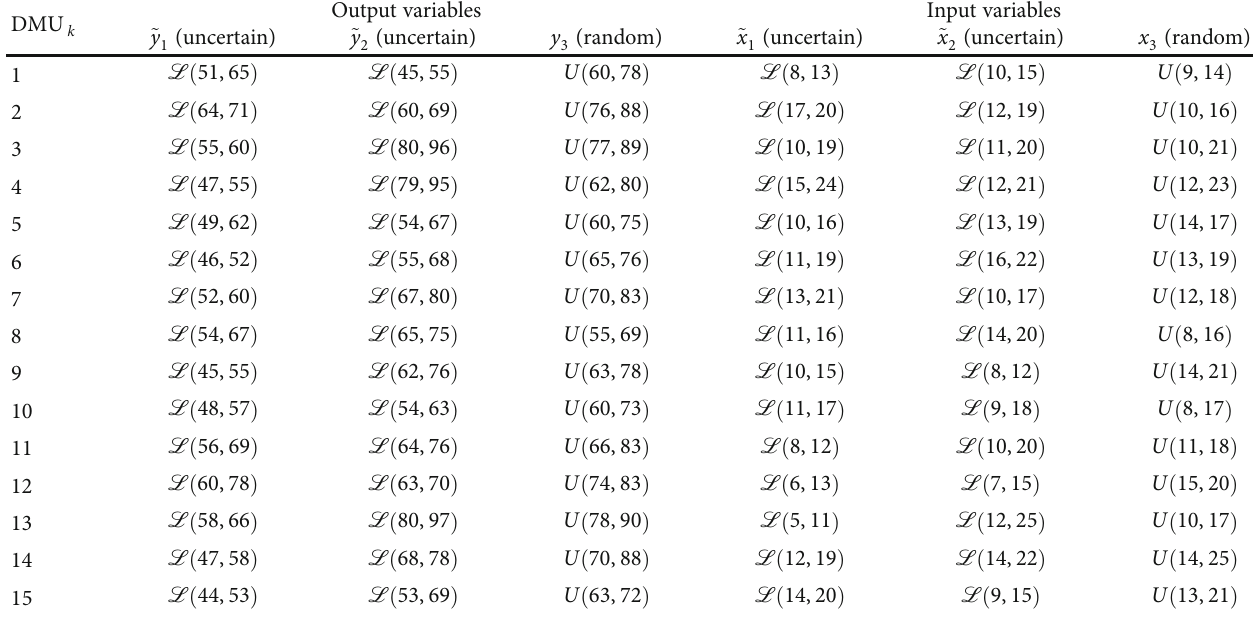
Table 1: Fifteen DMUs with three inputs and three